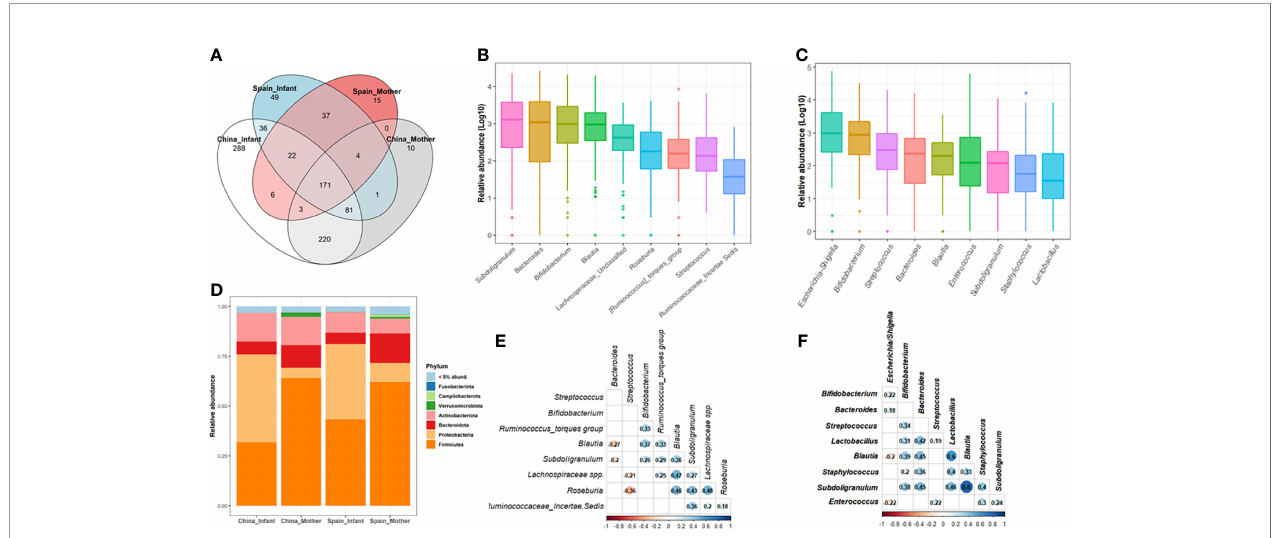
FIGURE 1 | Microbial composition of maternal-neonatal microbiota in both populations, China and Spain. (A) Venn diagram of the shared genera between mothers and neonates as well as both populations. (B, C) The relative abundance distribution of the core genera in the whole maternal (B) and neonatal group (C) . Microbiota data at genus level was transformed to log10-values for plotting [log (x+1)]. (D) The microbial composition of the whole population at phylum level according to both geographical location and mother/infant category. Phyla with a relative abundance lower than 5% were groups as “ Others ” . (E, F) Co-occurrence patterns among the core genera across the 120 maternal (E) and neonatal (F) samples determined as Spearman ’ s correlation. Data were transformed to relative abundance for correlations analysis. Only the signi fi cant relations are